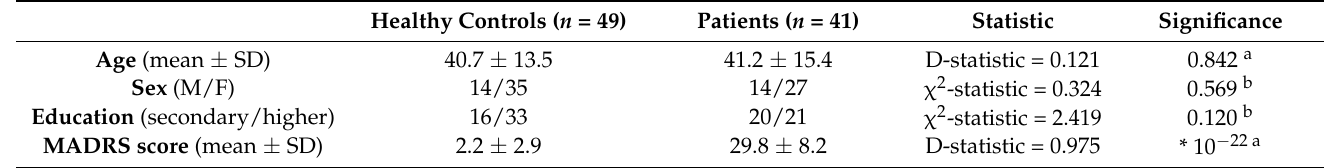
Table 1. Demographic and clinical characteristics of the groups. Healthy Controls ( n =